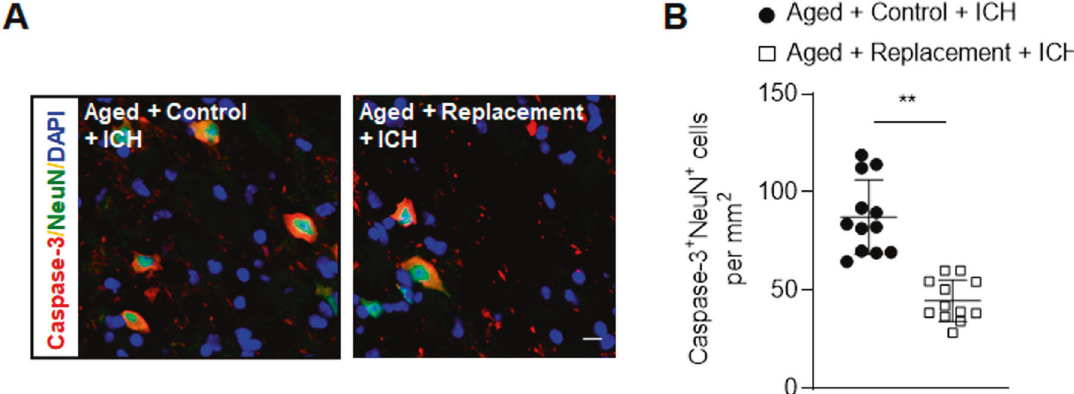
Fig. 4 Effects of microglial replacement on neuronal death after ICH in the aged mice. ICH was induced in mice by injection of collagenase. A Brain sections from groups of ICH mice receiving indicated treatments after ICH were stained with NeuN (green) and Caspase-3 (red) at day 3 after ICH. Nuclei were stained with DAPI (blue). Scale bar: 10 µm. B Counts of Caspase-3 + NeuN + cells from groups of ICH mice receiving indicated treatments after ICH. n = 12 per group. Data are presented as mean ± SD. ** p <